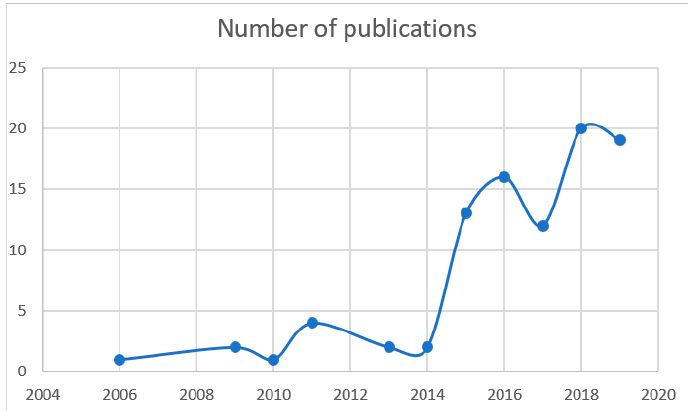
Figure 1. Number of publications of the studied literature collection (source: own study).